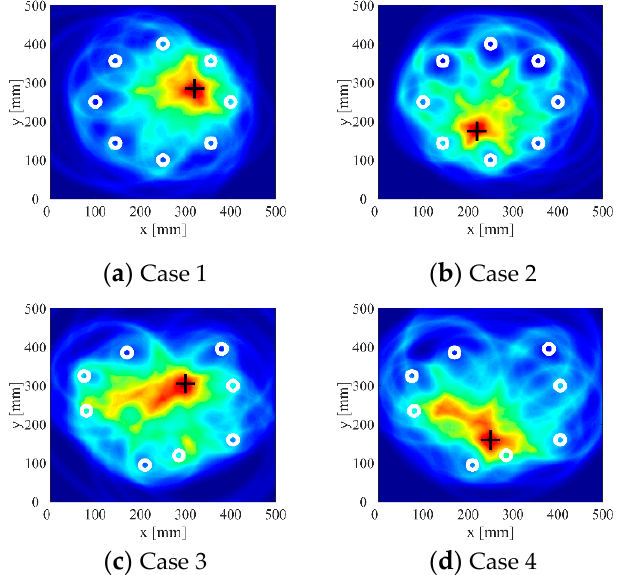
Figure 12. Imaging results of probabilistic ellipse based on adaptive signal truncation method.